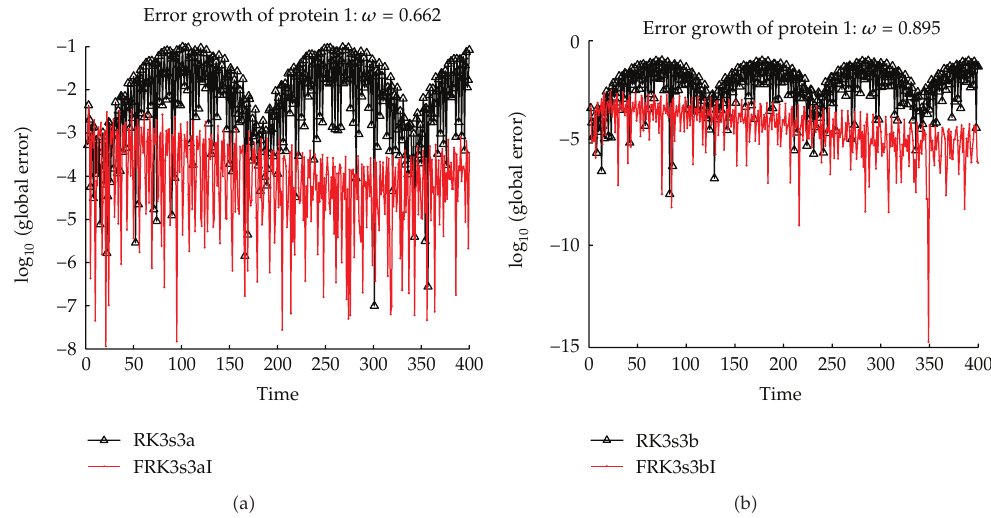
Figure 2: Comparison of (cid:3) a (cid:4) RK3s3a and FRK3s3aI (cid:3) left (cid:4) , (cid:3) b (cid:4) RK3s3b and FRK3s3bI (cid:3) right (cid:4) .